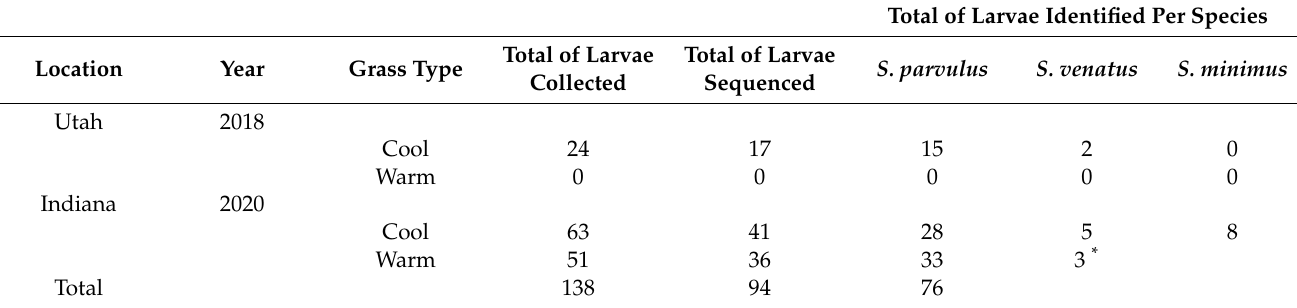
Table 3. Summary of larval specimens collected at Utah 2018 and Indiana 2020 in cool- and warm-season turfgrass. The total number of each species identified at each location and type of grass (* cool-season or ° warm-season) is included.